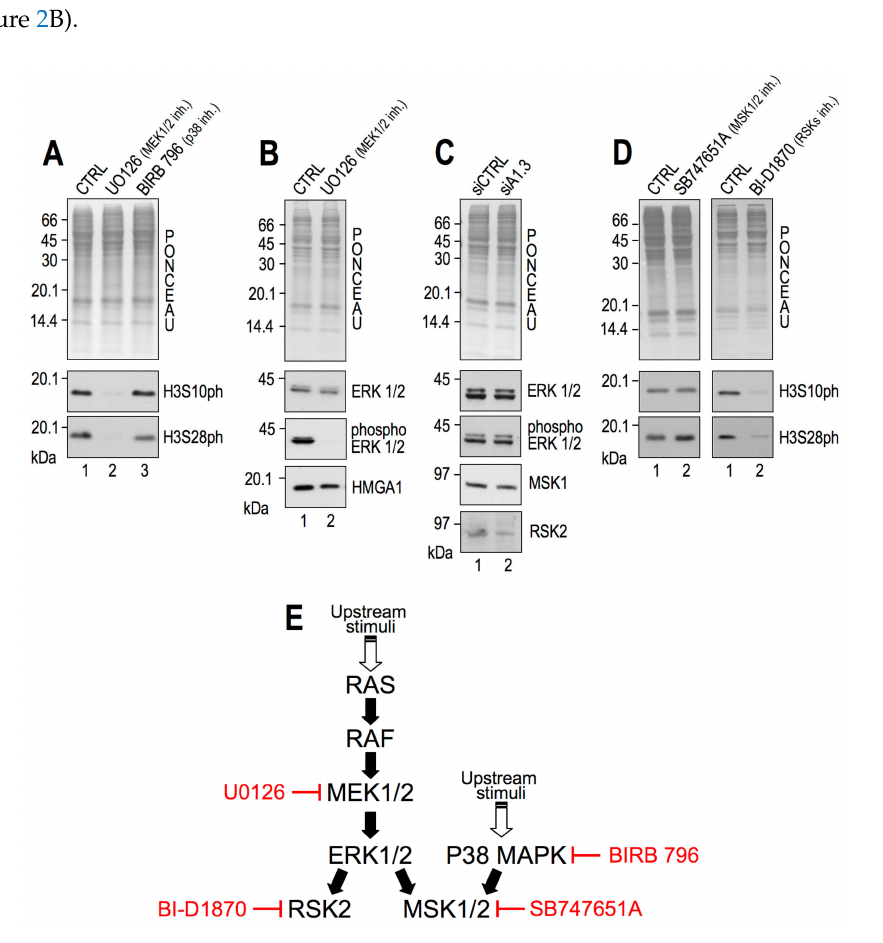
Figure 2. H3S10ph and H3S28ph are mediated by the extracellular-signal-regulated kinase / ribosomal protein S6 kinase alpha-3 (ERK / RSK2) pathway in MDA-MB-231 cells. Western blot (WB) analyses performed with MDA-MB–231 lysates. ( A ) Cells treated for 24 h with 10 µ M U0126 (lane 2), 10 µ M BIRB796 (lane 3), or dimethyl sulfoxide (DMSO) as control (CTRL, lane 1). ( B ) Cells treated for 24 h with 10 µ M UO126 (lane 2) and DMSO as control (CTRL, lanes 1). ( C ) Cells transfected with control (siCTRL, lane 1) or HMGA1–targeting (siA1_3, lane 2) small interfering RNAs. The HMGA1 silencing e ffi cacy of siA1_3 treatment is shown in Figure 1. ( D ) Left side: cells treated for 24 h with 10 µ M SB747651A (lane 2) and DMSO as control (CTRL, lanes 1). Right side: cells treated for 24 h with 10 µ M BI–D1870 (lane 2) and DMSO as control (CTRL, lanes 1). Representative red ponceau-stained membranes are shown as loading and quantification controls. Molecular weight markers (kDa) are indicated on the left. All WB experiments were performed in biological triplicate, providing consistent results. Representative images are shown. ( E ) Summary of all the inhibitors used and their